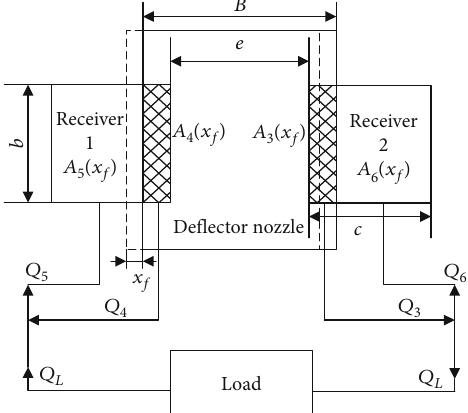
Figure 9: The relative position between the nozzle of the de fl ector and the receiver.